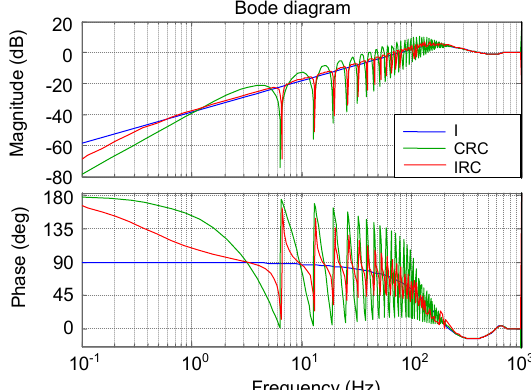
Fig. 13 | Sensitivity function responses in frequency